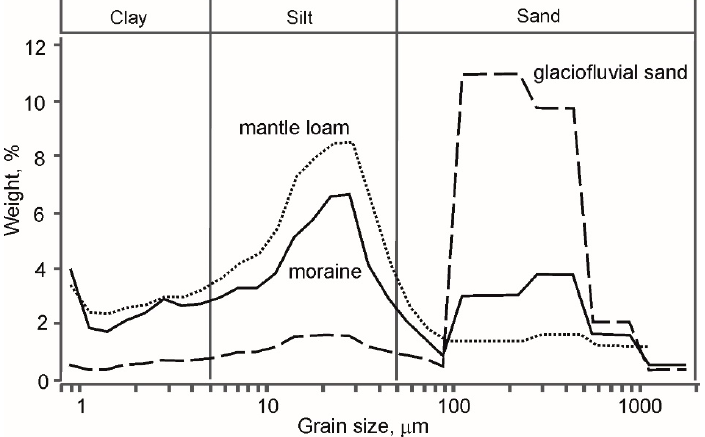
Figure 7. The grain size distribution of different lithological units in the Senokosnaya